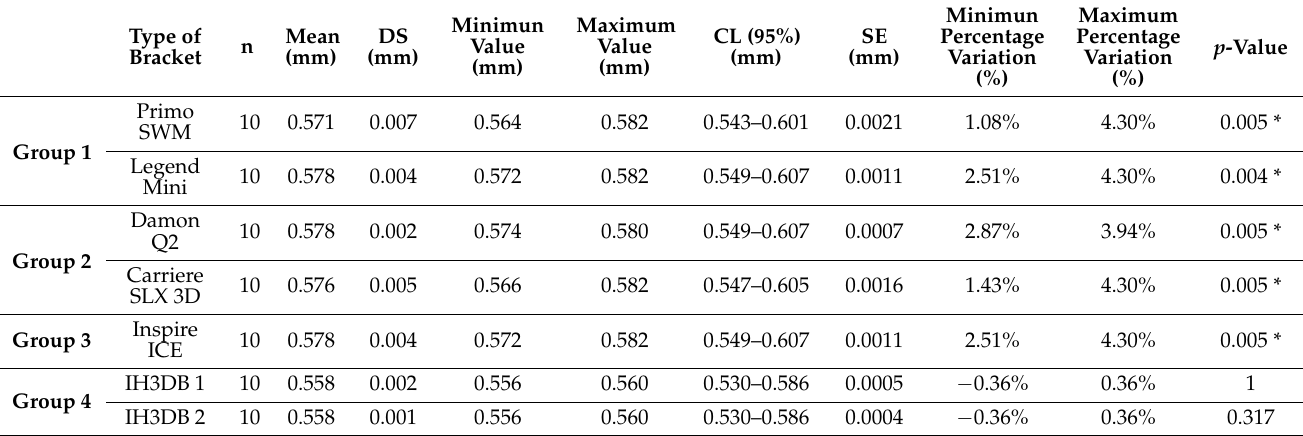
Table 3. Descriptive analysis of each type of bracket investigated. SD: standard deviation; CL: confidence limit; SE: standard error and comparative analysis of measured and nominal slot heights for each type of bracket investigated ( p < 0.05 *).